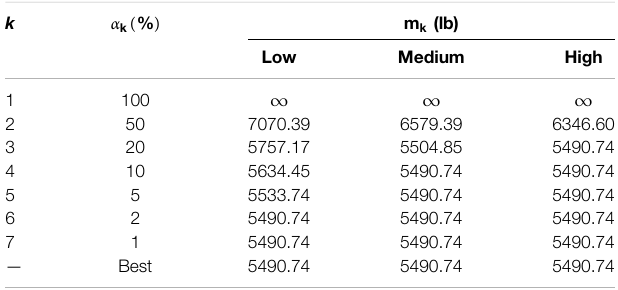
TABLE 2 | Performance threshold values in stage k for a low, medium and high computational budget.